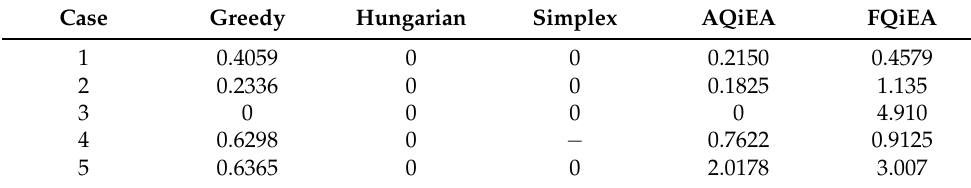
Table 5. Optimality gap α for the case studies.